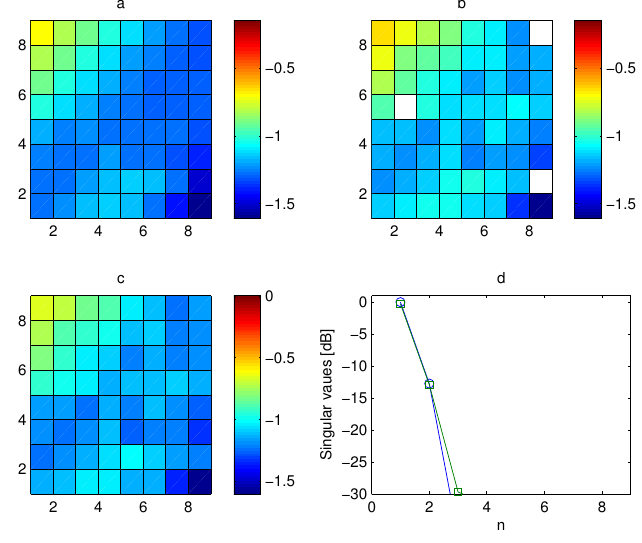
Figure 13. 9 × 9 MIMO system in a corridor, in amplitude of the channel matrix; ( a ) exact (noise-free); ( b ) measured; ( c ) estimated; ( d ) singular value of the exact (circles) and estimated (squares) matrices; the geometry of the problem is shown in Figure